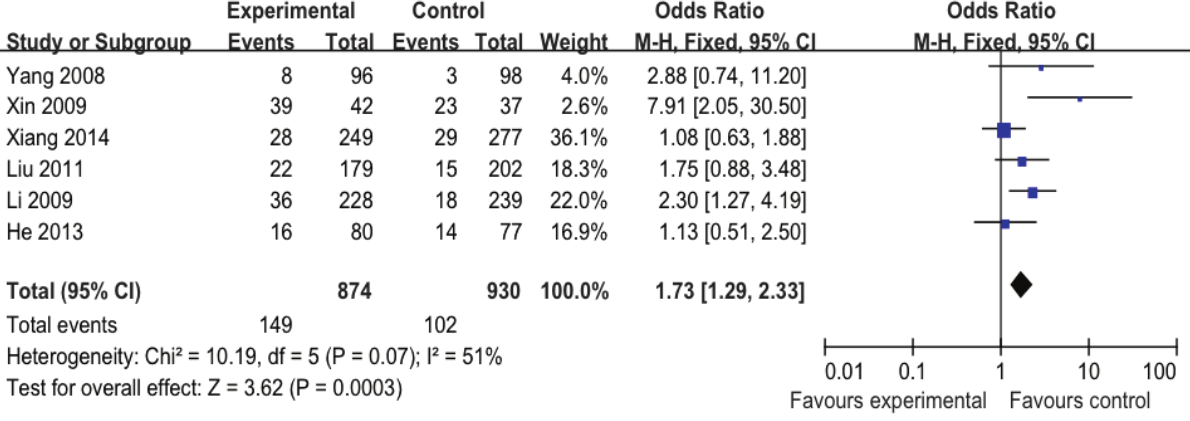
Figure 1: Forest plot of correlation between adiponectin gene rs22411766 T>G polymorphism and ischemic stroke in GG vs TT genetic